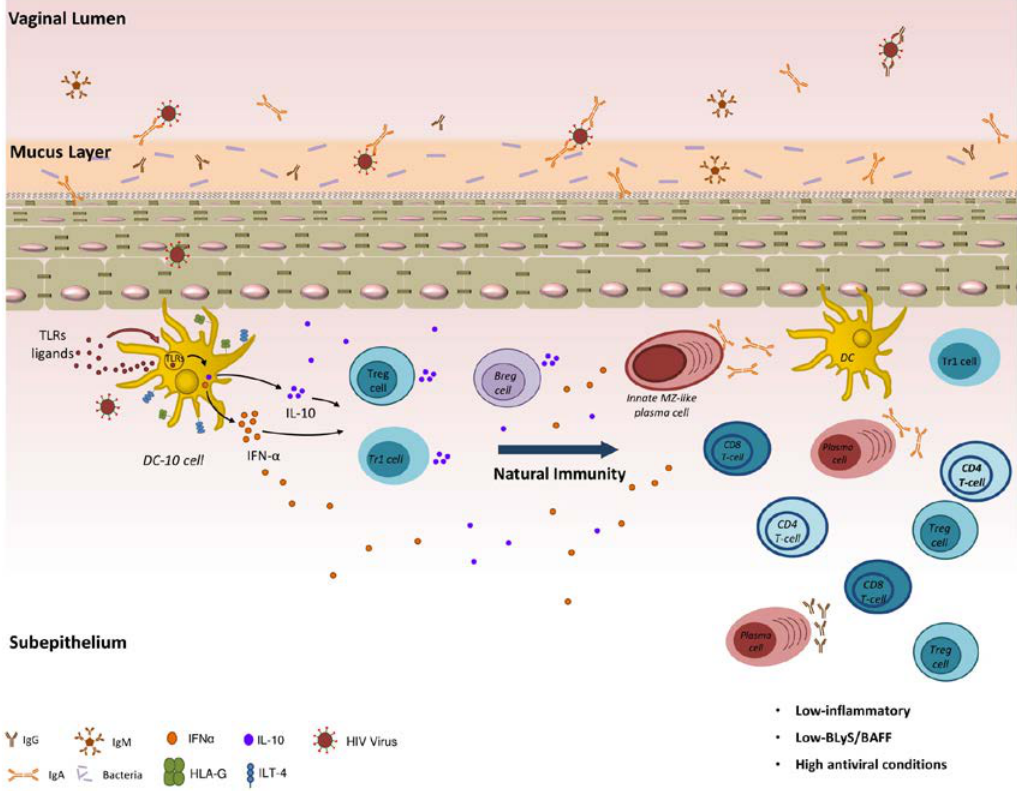
Figure 1. Natural genital mucosal immunity to HIV.